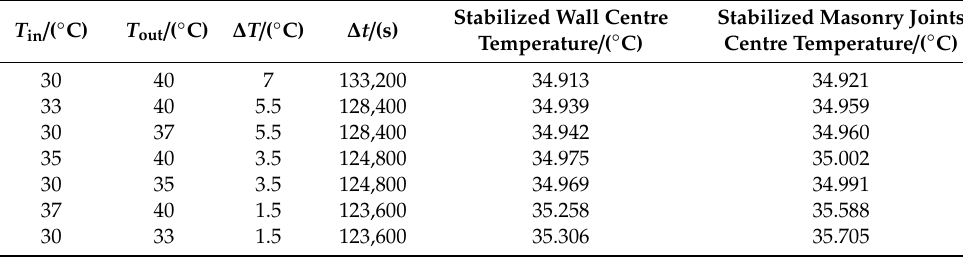
Table 5. Statistical results of di ff erent decanoic acid working